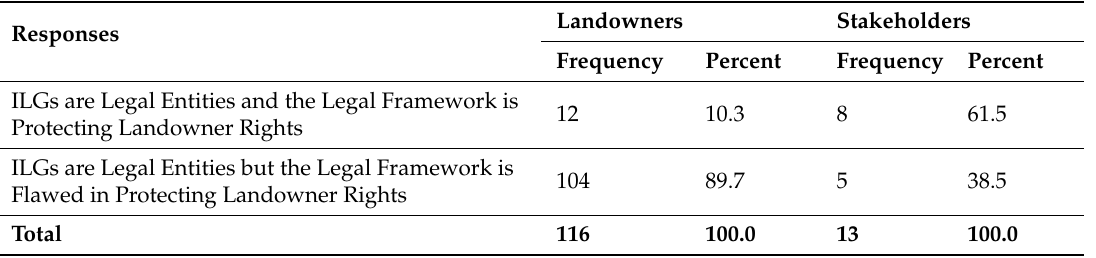
Table 6. Landowners’ and Stakeholders’ Perceptions of Legality of ILGs and their Legal Framework.